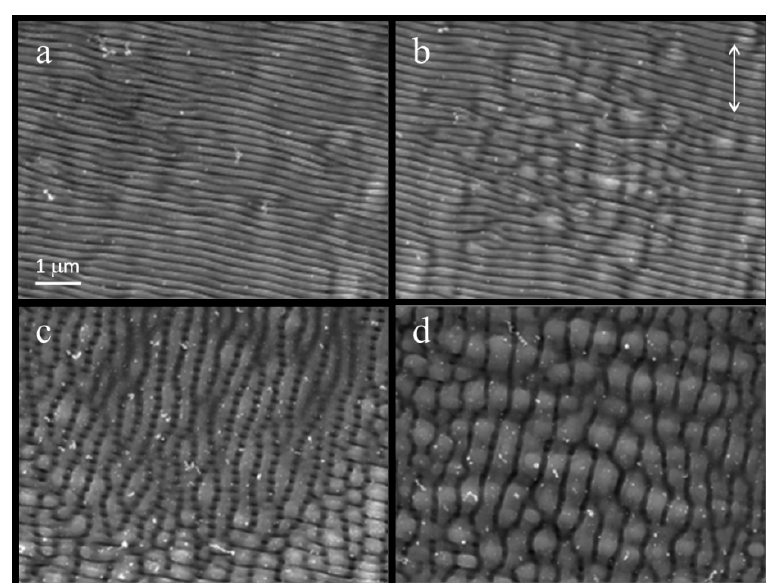
Figure 8. Surface structures on (001) rutile TiO 2 obtained after laser irradiation (248 nm, 450 ps, NP = 100) with total measured fluence of 250 mJ/cm² and delay between pulses of 0 ps ( a ), 4 ps ( b ), 10 ps ( c ) and 30 ps ( d ). Doubled–ended arrow indicates laser polarisation direction.